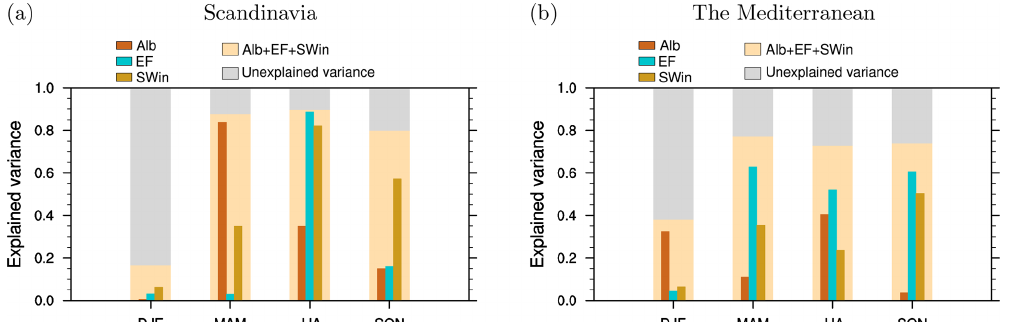
Figure 12. Fraction of inter-model variance in 2m temperature change (FOREST minus GRASS) explained by changes in albedo, evapora- tive fraction, incoming surface shortwave radiation or the three combined. Alb: inter-model correlation (Rsquared) between changes in albedo and 2m temperature. EF: inter-model correlation (Rsquared) between changes in evaporative fraction and 2m temperature. SWin: inter- model correlation (Rsquared) between changes in incoming surface shortwave radiation and 2m temperature. Alb + EF + SWin: Rsquared of a multi-linear regression combining the three predictors. Results for other regions are shown in the Supplement.